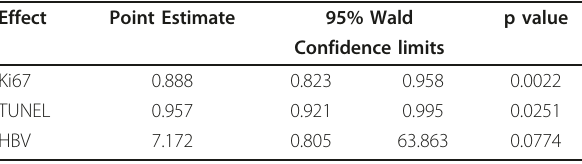
Table 3 Independent predictors of negative SCCA staining